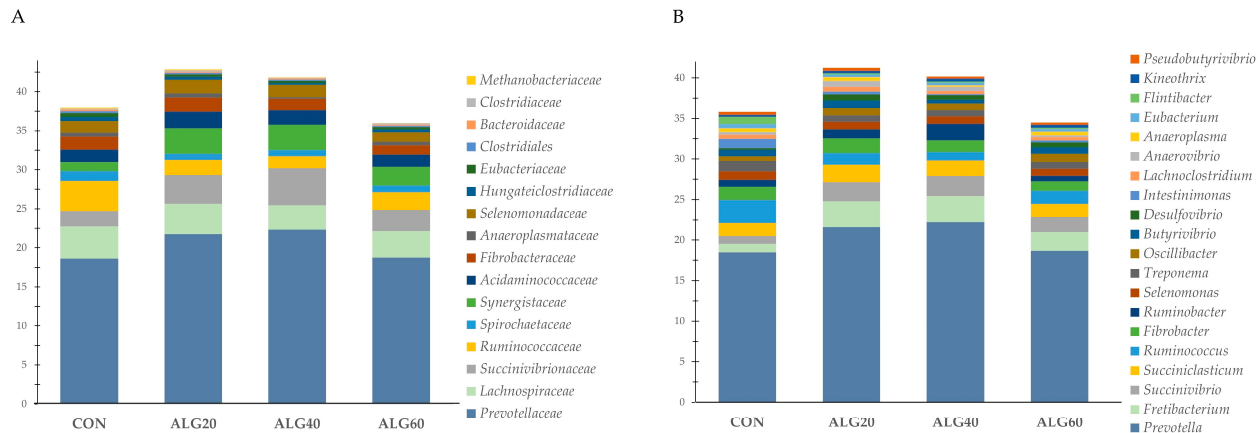
Figure 3. Relative abundances of the most dominant ( A ) families (>0.1%) and ( B ) genera (>0.3%) in the four dietary treatments (CON, ALG20, ALG40, and ALG60) within the two sampling times (20th and 40th days) illustrated in the cumulative bar graph. CON = control concentrate without microalgae ( Schizochytrium spp.); ALG20 = CON with 20 g/Kg Schizochytrium spp.; ALG40 = CON with 40 g/Kg Schizochytrium spp.; ALG60 = CON with 60 g/Kg Schizochytrium spp.